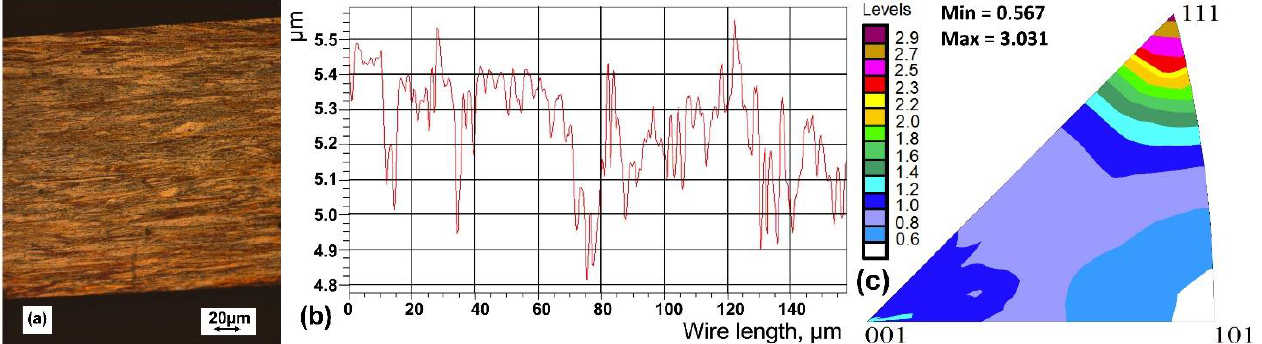
Figure 1. Results of the experimental study of the initial wire: ( a ) microstructure (light microscope); ( b ) example surface profile in the longitudinal direction; ( c ) crystallographic textures of initial wire (the inverse pole figure).